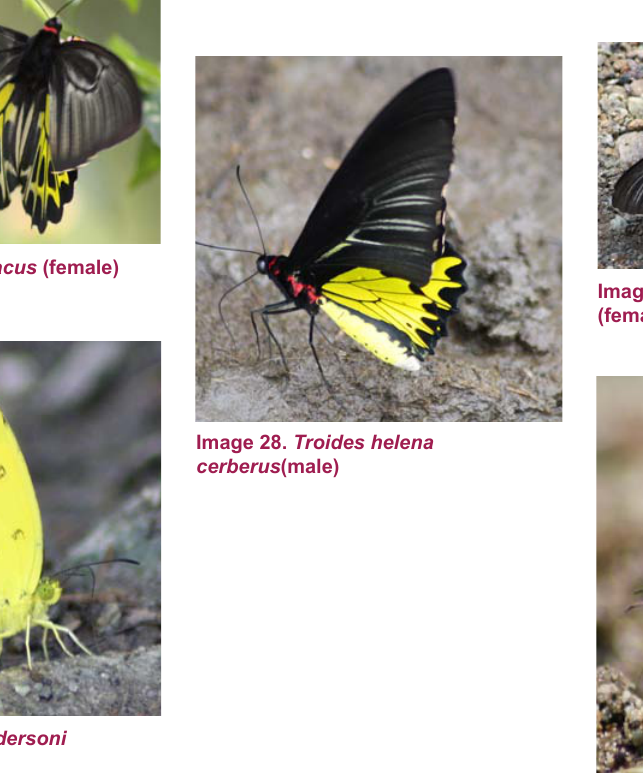
Image 25. Papilio polyctor ganesa Image 26. Troides aeacus (male)